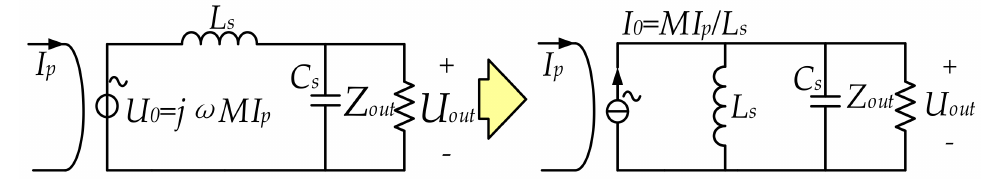
Figure 3. The equivalent circuit model at the secondary